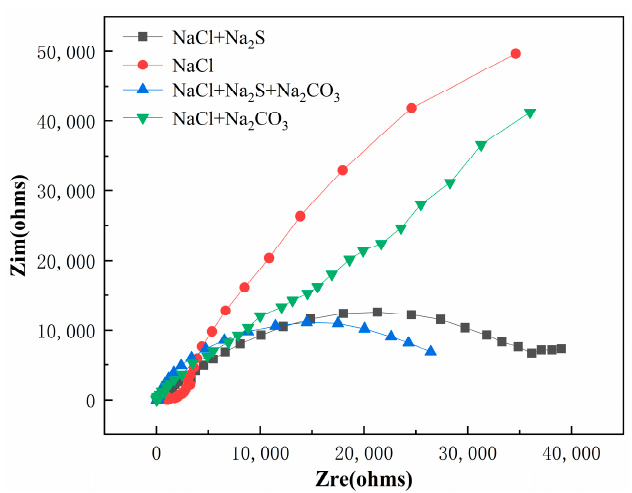
Figure 6. Alternating-current impedance diagram of TC4 titanium alloy under di ff erent corrosion environments.